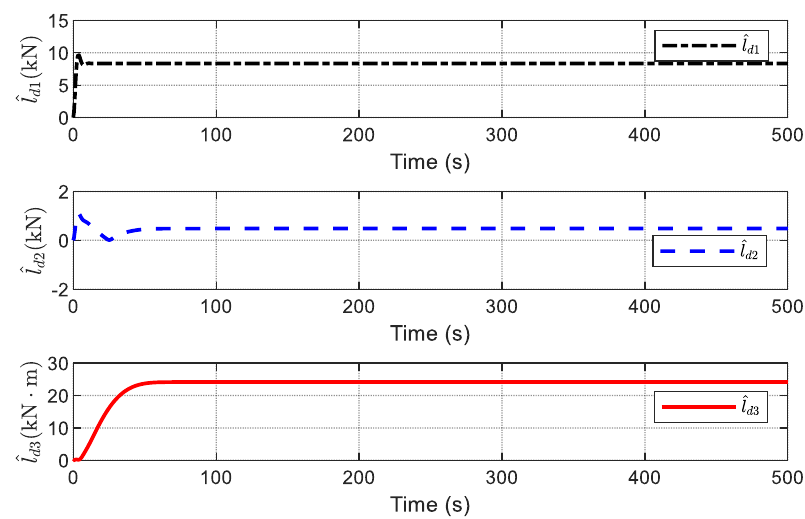
Figure 13. Estimation of the upper bound of the disturbances via ADO.